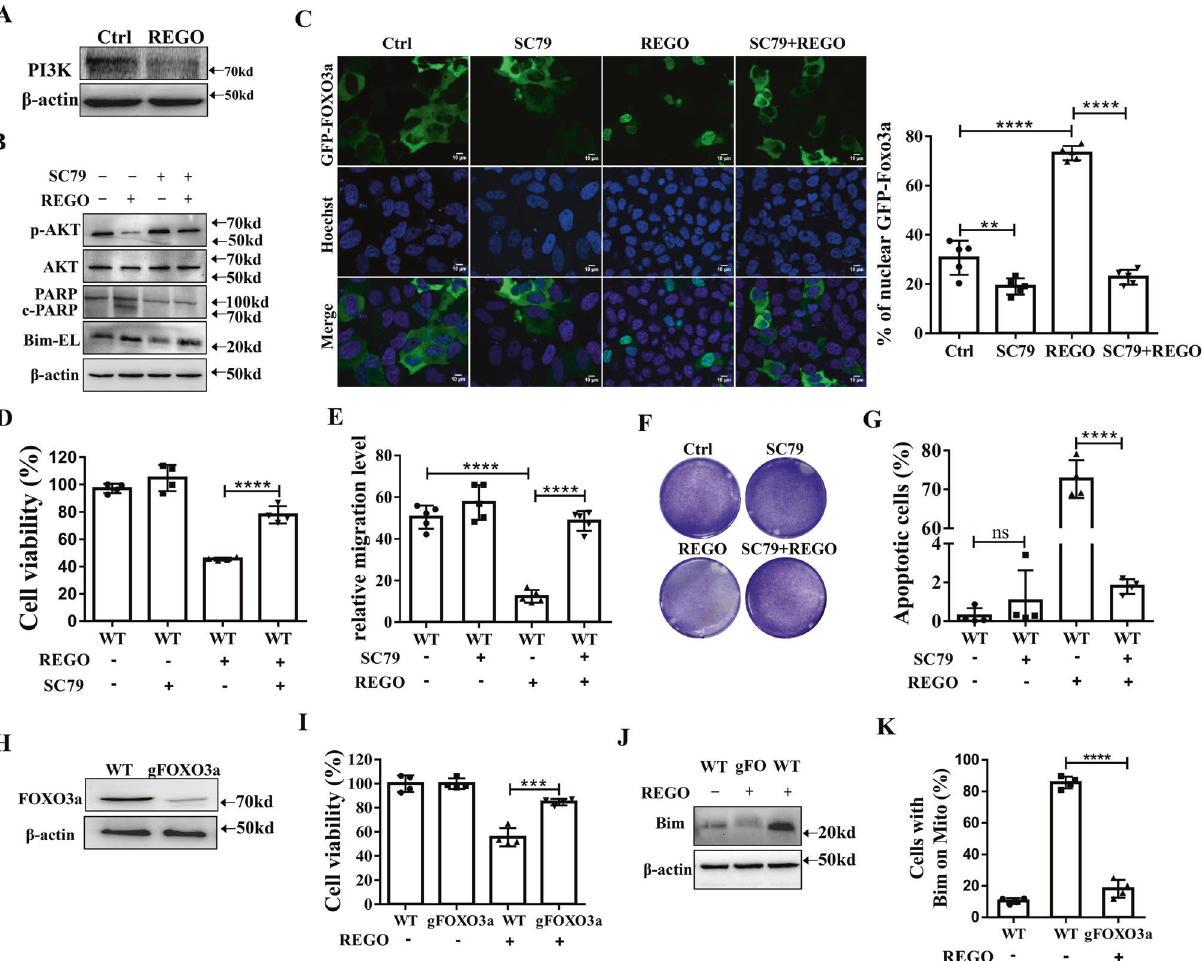
Fig. 3 REGO induces apoptosis by inhibiting the PI3K/AKT/FOXO3a signaling pathway. A Western blotting analysis on the REGO-down- regulated PI3K. B Western blotting analysis on the inhibitory effect of SC79 on REGO. Cells were pretreated with SC79 (10 mM) for 2 h, followed by co-treatment with REGO at 20 μ M for 24 h. C Representative fl uorescence images of cells expressing GFP-FOXO3a in the presence or absence of REGO. Scale bar: 10 μ m. Statical percentage of cells with GFP-FOXO3a nuclear localization. n ≥ 100 cells. D Inhibitory effect of SC79 on the cytotoxicity of REGO measured by CCK-8 assay. Cells were pretreated with SC79 (10 mM) for 2 h, followed by co-treatment with REGO at 20 μ M for 24 h. E SC79 prevents the REGO-induced loss of cells migration assessed by wound healing assay. Representative images of MCF-7 cells are shown as micrographs (×100). F SC79 restores REGO-induced proliferation of MCF-7 cells was assessed by a cell colony formation assay. G Flow cytometry analysis on the inhibitor effects of SC79 on REGO-induced apoptosis. H Western blotting analysis con fi rmed CRISPR/ Cas9-mediated knockout of FOXO3a. I FOXO3a was required for REGO-induced cytotoxicity measured by CCK-8 assay. J Western blotting analysis on FOXO3a was involved in REGO-triggered Bim expression. K Statistical percentage of cells mitochondrial YFP-Bim on. n ≥ 100 cells. ** p < 0.01, *** p < 0.001, **** p < 0.0001, ns (no signi fi cant) p > 0.05. All data are expressed with the mean ± SD of three independent